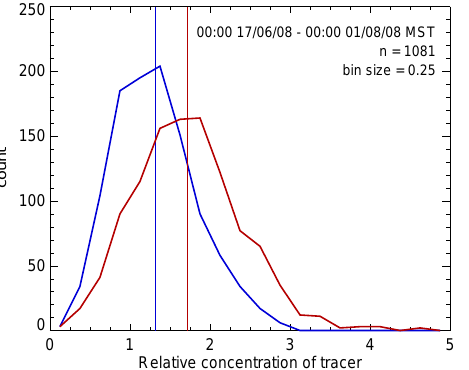
Fig. 9. A comparison of observed and modelled surface bromoform mixing ratios for Danum Valley and Kunak. Modelled mixing ra- tios are calculated using p-TOMCAT, with rest of world emissions as Scenario 5, Warwick et al. (2006) and SEA emissions scaled to 30Gg CHBr 3 /yr (16Gg CHBr 3 /yr from SEA open ocean and 14Gg CHBr 3 /yr from SEA coastlines). Global emissions in this scenario total 382Gg CHBr 3